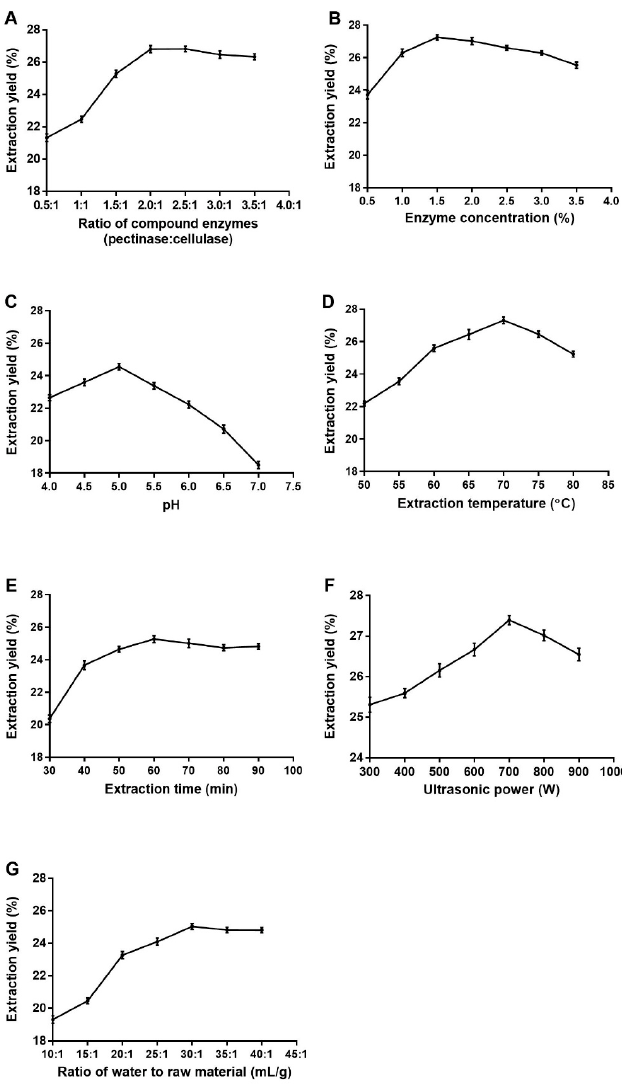
Fig. 2: Effect of different extraction factors (A) ratio of compound enzymes, (B) enzyme concentration, (C) pH value, (D) extraction temperature, (E) extraction time, (F) ultrasonic power, (G) ratio of water to raw material on extraction yield of TPs.